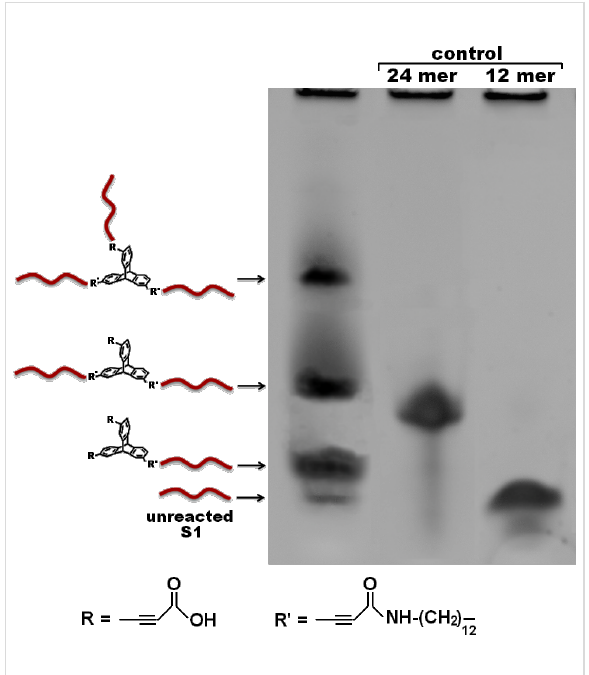
Figure 1: 20% denaturing PAGE analysis of DNA (S1)–TPA conju- gates showing a decrease in gel mobility of the conjugates upon successive conjugation of ssDNA strands to the triptycene